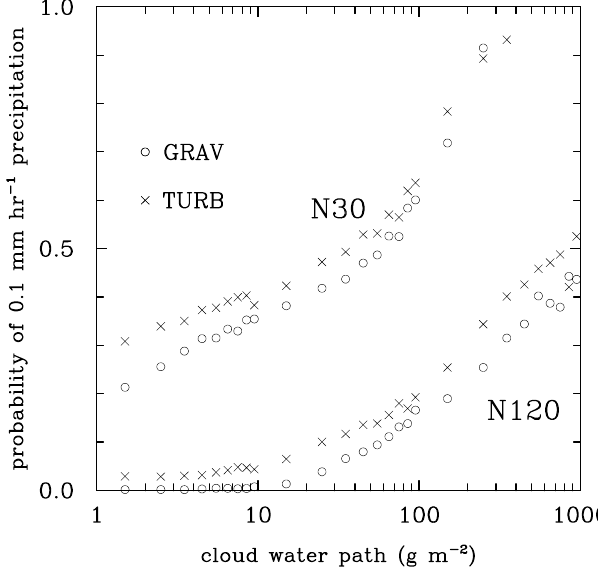
Figure 7. Probability of the 0.1mmh − 1 precipitation for TURB and GRAV simulations N30 and N120 as a function of the cloud water path for the last 3h of the